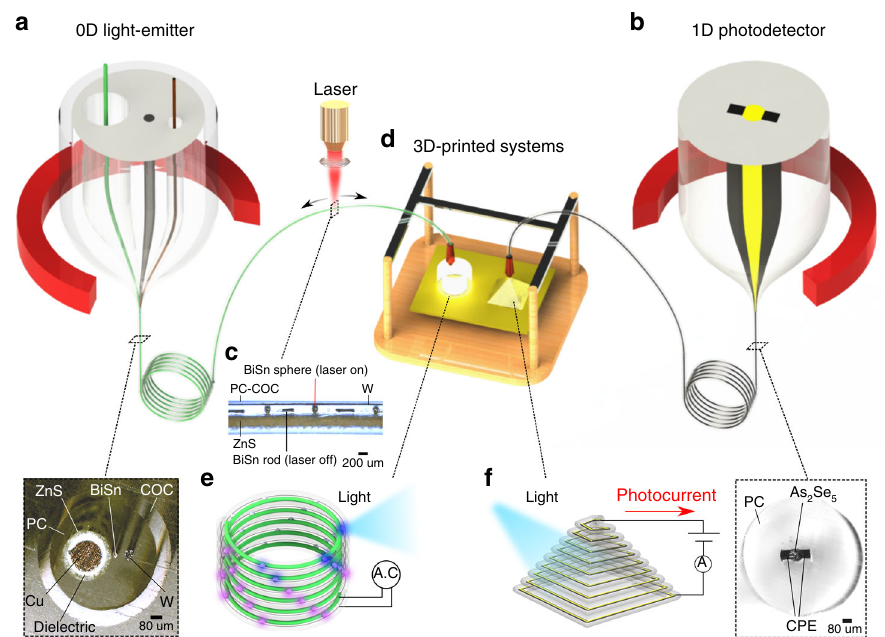
Fig. 1 Designable structured multimaterial fi lament inks for three-dimensional printed functional systems. Thermal-drawing of multimaterial preforms into a 0-dimensional light-emitting and b 1-dimensional light-detecting fi laments, with their corresponding cross-sectional optical micrographs of metal- insulator-semiconductor 3D microstructures. c Spatially-resolved laser-induced capillary formation of discrete BiSn spheres to form programmably-placed pixels within the light-emitting fi lament. d These microstructured fi laments are fed into a regular fused fi lament fabrication printer with a modi fi ed nozzle, enabling the tailored formation of electrically-activated three-dimensional systems capable of spatial e light-emission and f light-detection from its entire